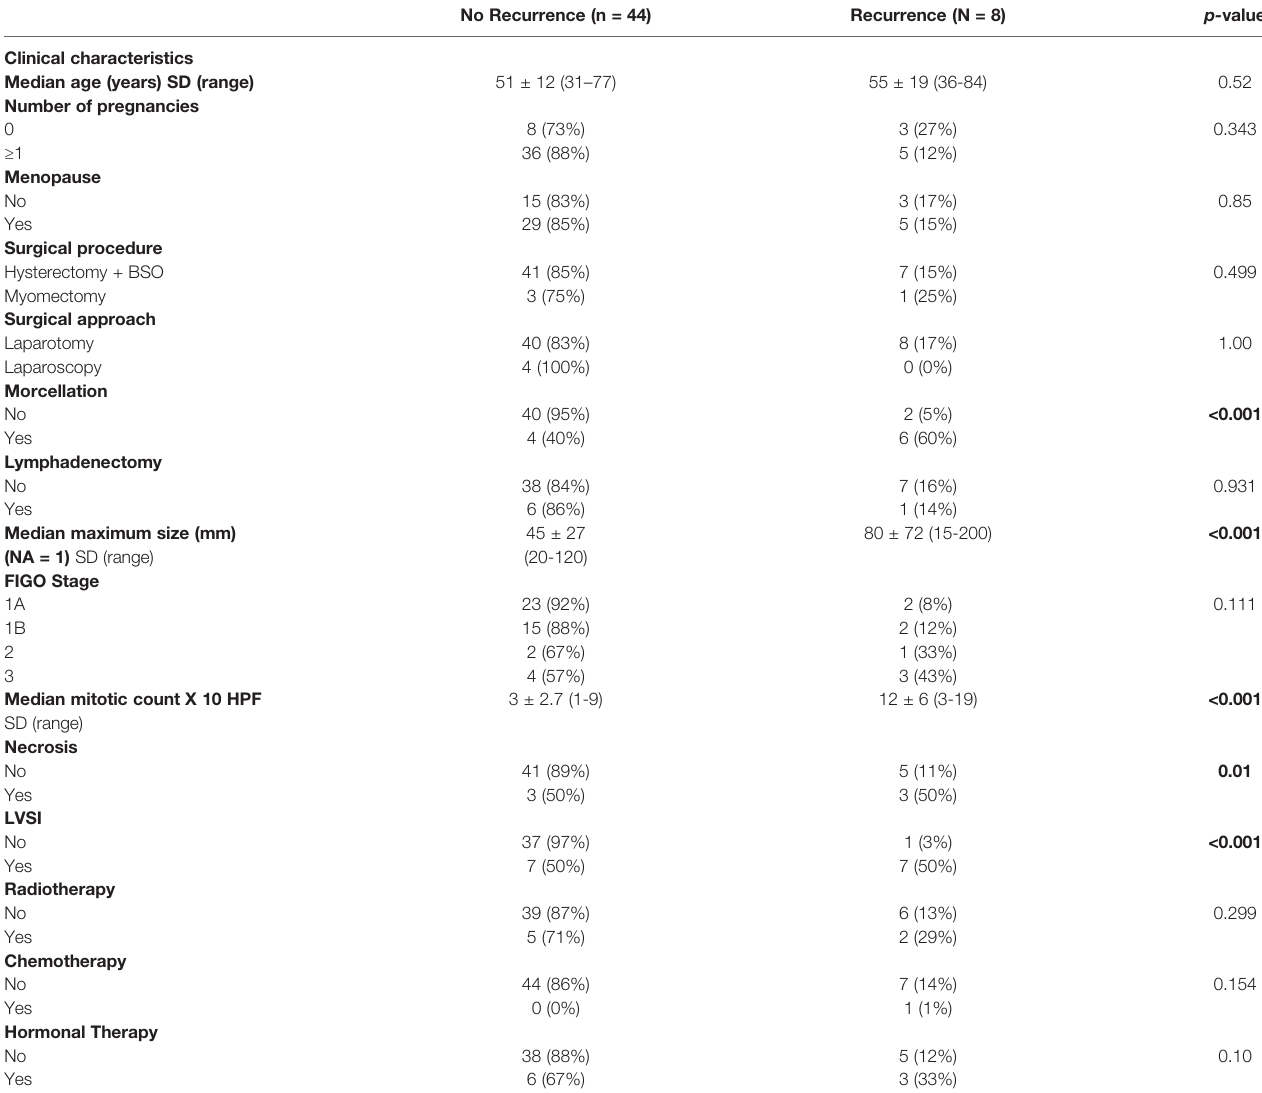
TABLE 1 | Clinical and pathological features according to recurrence of 52 patients affected by LG-ESS (in bold signi fi cant p -values). No Recurrence (n =